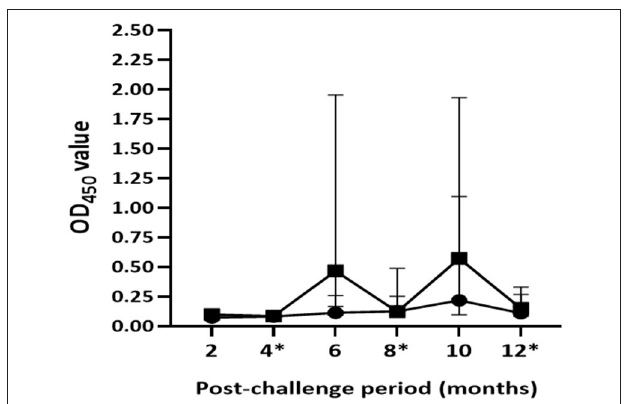
FIGURE 6 | Post-exposure antibody responses in the experimental calves. The figure shows dynamics of the humoral immune response in the vaccinated and control calves during 12 months of exposure. Results were expressed by OD 450 value of the antibody response. Solid circle and solid square error bars indicate the median ( ± 95% CI) OD 450 value of vaccinated and control calves, respectively. The magnitude of antibody responses significantly ( p < 0.001) increased in the vaccinated calves at the 6th and the 10th month compared to those of the control calves. Asterisks indicate months at which the skin testing was done after